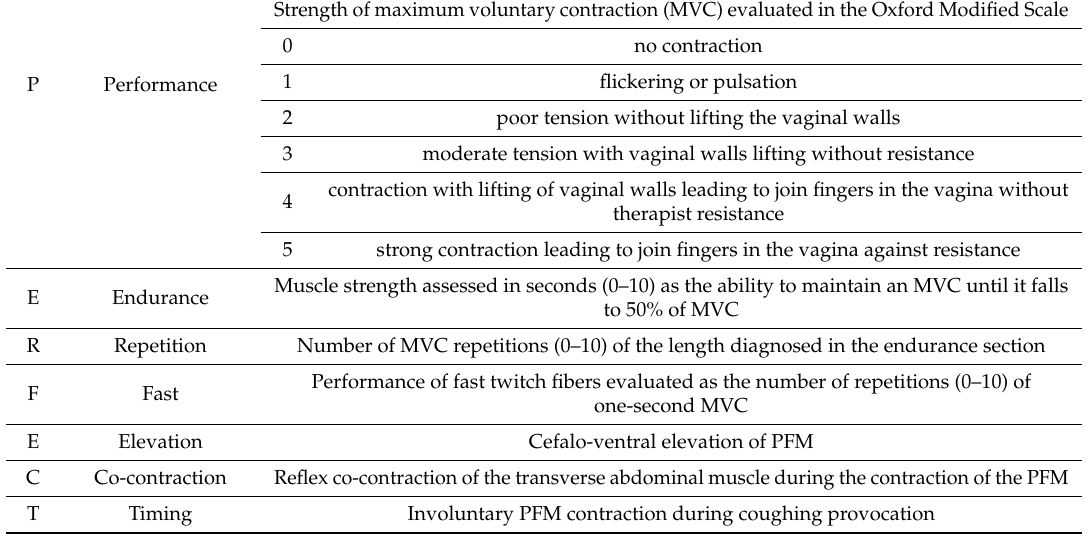
Table 1. PERFECT examination scheme of pelvic floor muscle